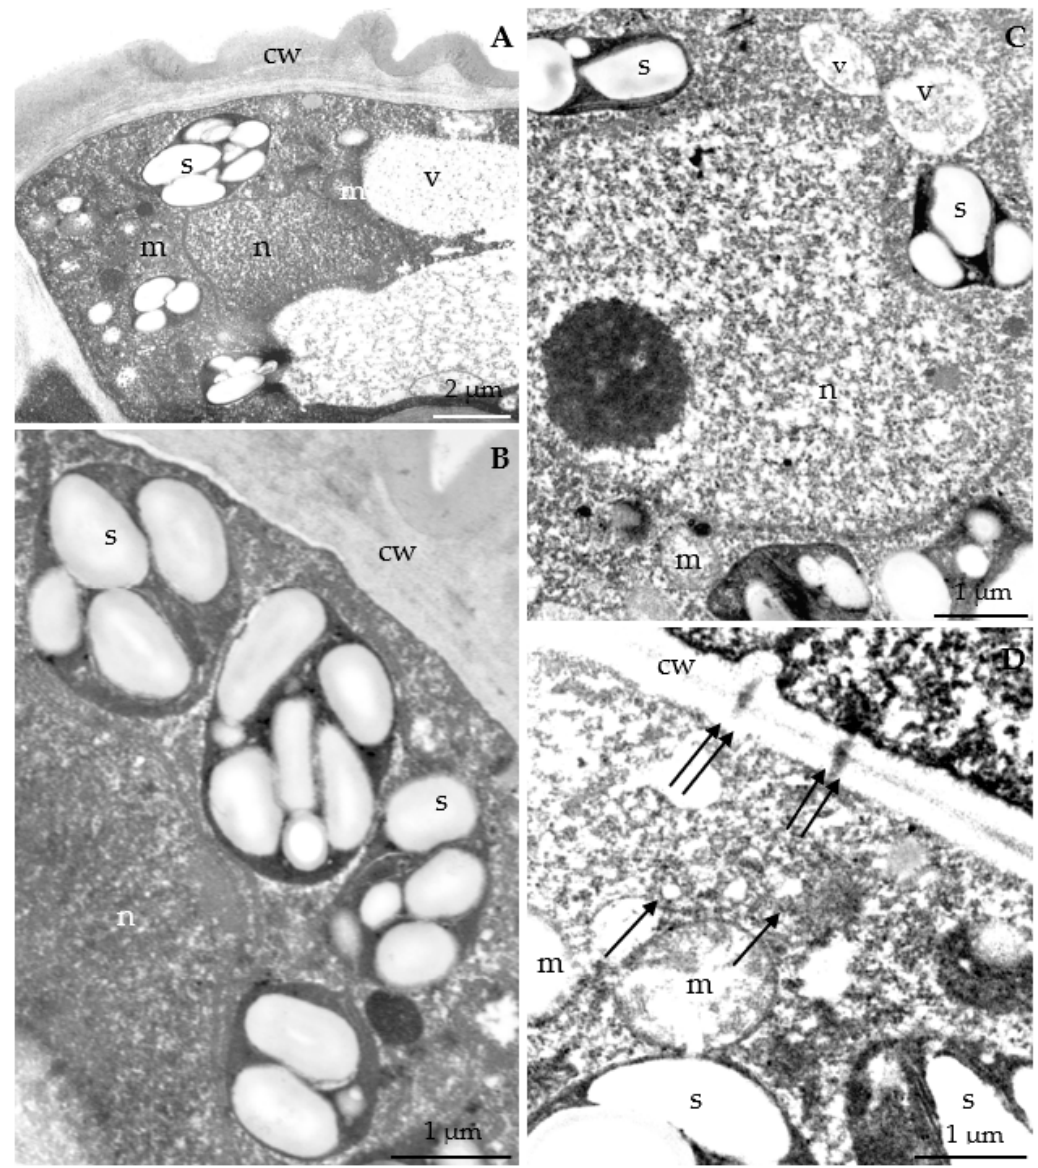
Figure 15. ( A – D ). Fragments of nectary epidermis ( A , B ) and parenchyma ( C , D ) cells in R. idaeus ‘Radziejowa’ in the initial secretion phase. ( A , B ): outer cell wall (cw) with convexities (micrograph A), amyloplasts with starch grains (s), vacuoles (v), cell nucleus (n), mitochondria (m). ( B ): amyloplasts with numerous starch grains (s) located near the outer cell wall (cw), cell nucleus (n). ( C ): starch grains (s) in plastids with located near the nucleus (n), mitochondrion (m), small vacuole (v). ( D ): plasmodesmata (two arrows) in the cell wall (cw), amyloplasts with starch grains (s), mitochondria (m), transport vesicles (arrow).